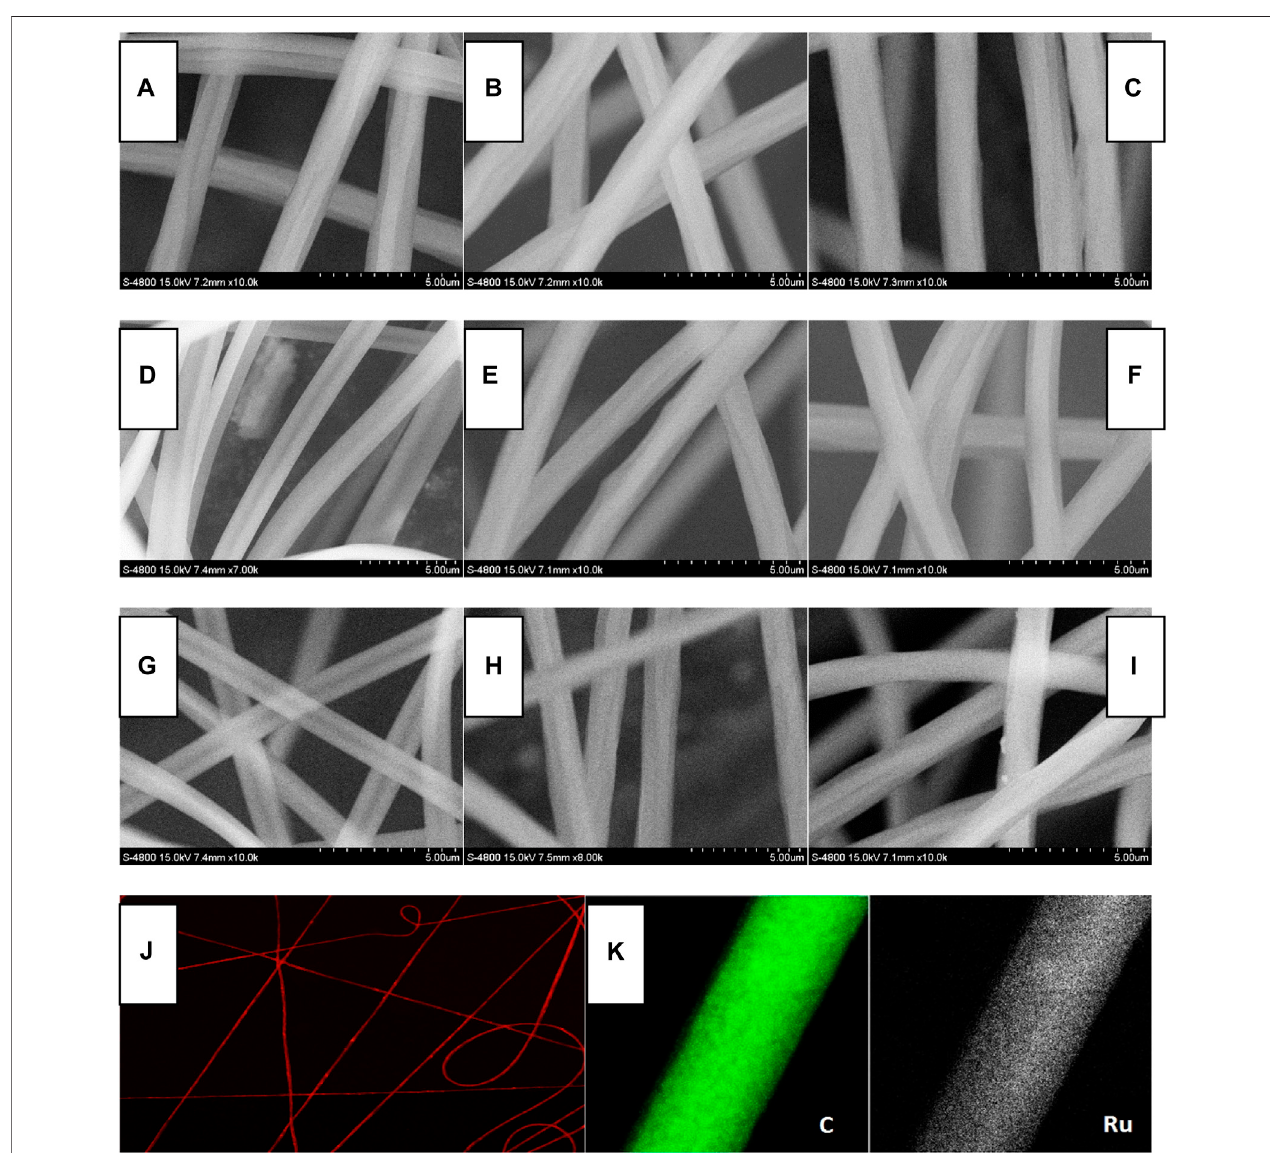
FIGURE 3 | SEM images of Ru-n@PS fi bers. (A) Ru-1@PS(10%), (B) Ru-1@PS(12%), (C) Ru-1@PS(15%), (D) Ru-2@PS(10%), (E) Ru-2@PS(12%), (F) Ru-2@ PS(15%), (G) Ru-3@PS(10%), (H) Ru-3@PS(12%), and (I) Ru-1@PS(15%). Fluorescence microscopy image (J) and EDX mapping (K) of Ru-1@PS(15%).